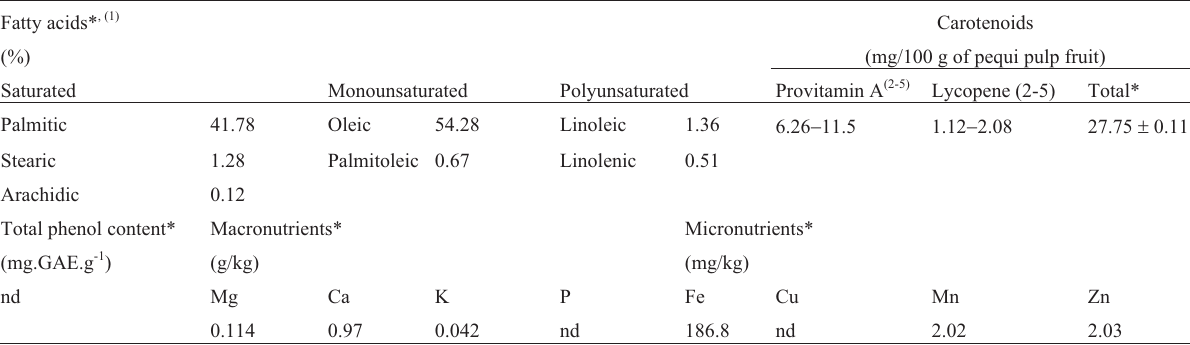
Table 1 - Relative composition of pequi ( Caryocar brasiliense Camb.) pulp oil. Fatty acids* ,(1)